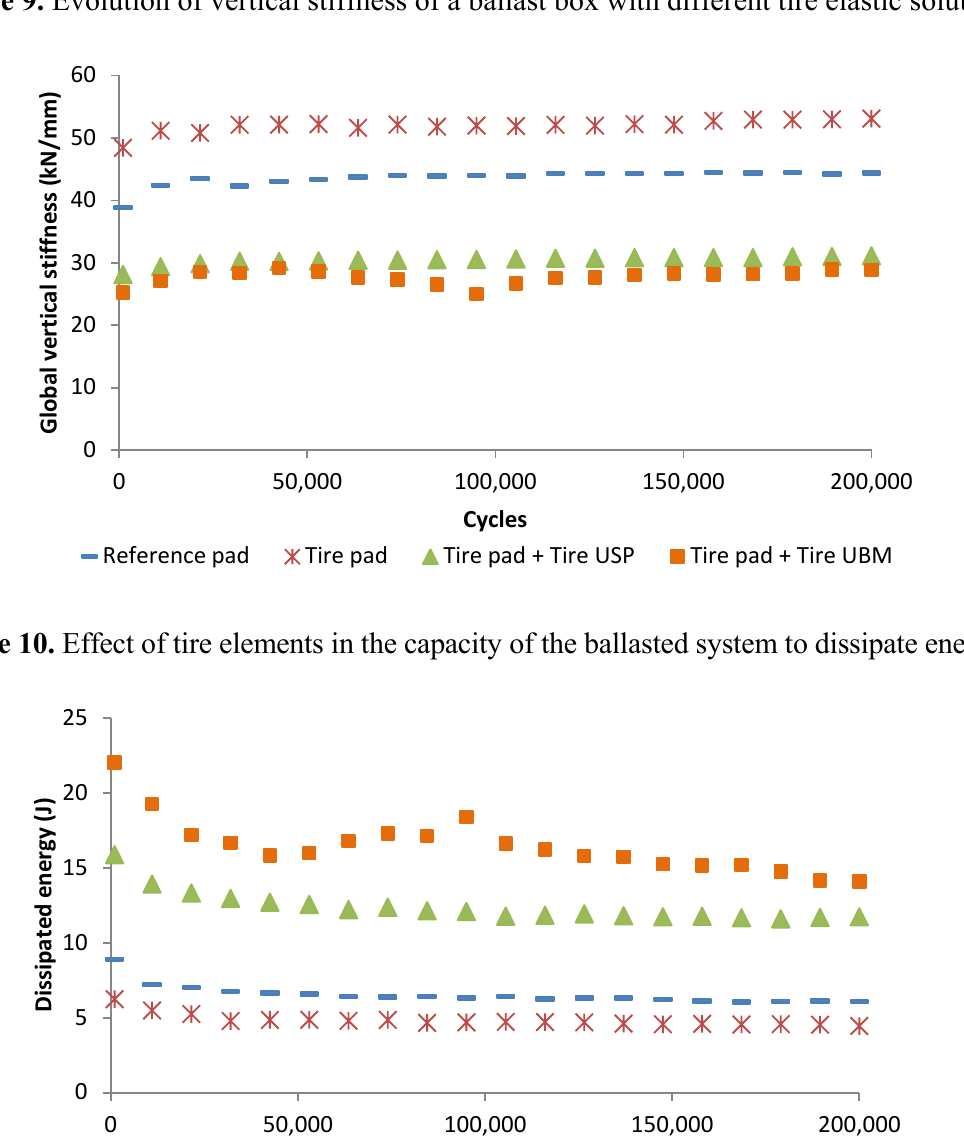
Figure 9. Evolution of vertical stiffness of a ballast box with different tire elastic solutions.